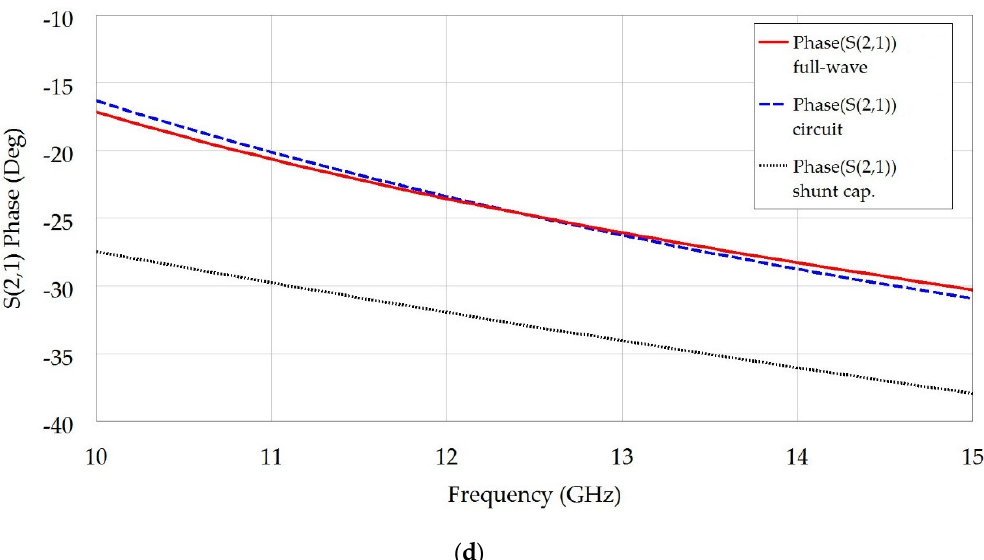
Figure 5. Symmetric E-plane iris scattering parameters for h = 3 mm. ( a ) |S 11 |; ( b ) |S 21 |; ( c ) ∠ S 11 ; ( d ) ∠ S 21 .